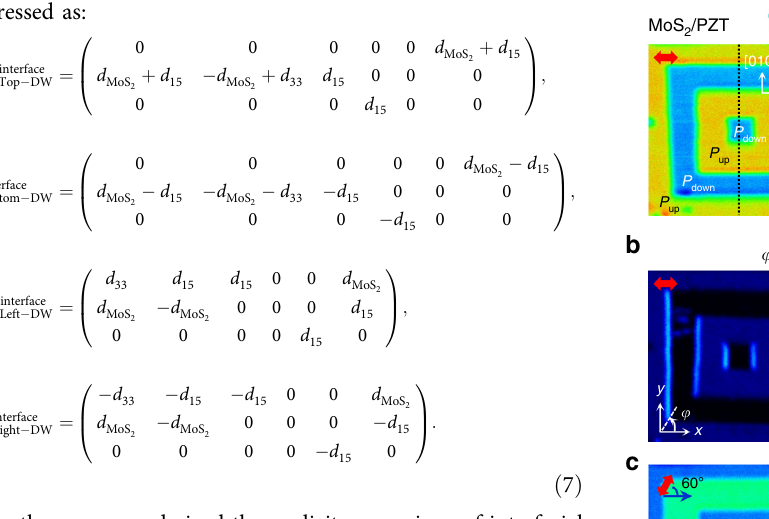
intensity in 1L MoS 2 /PZT heterostructures with different PZT